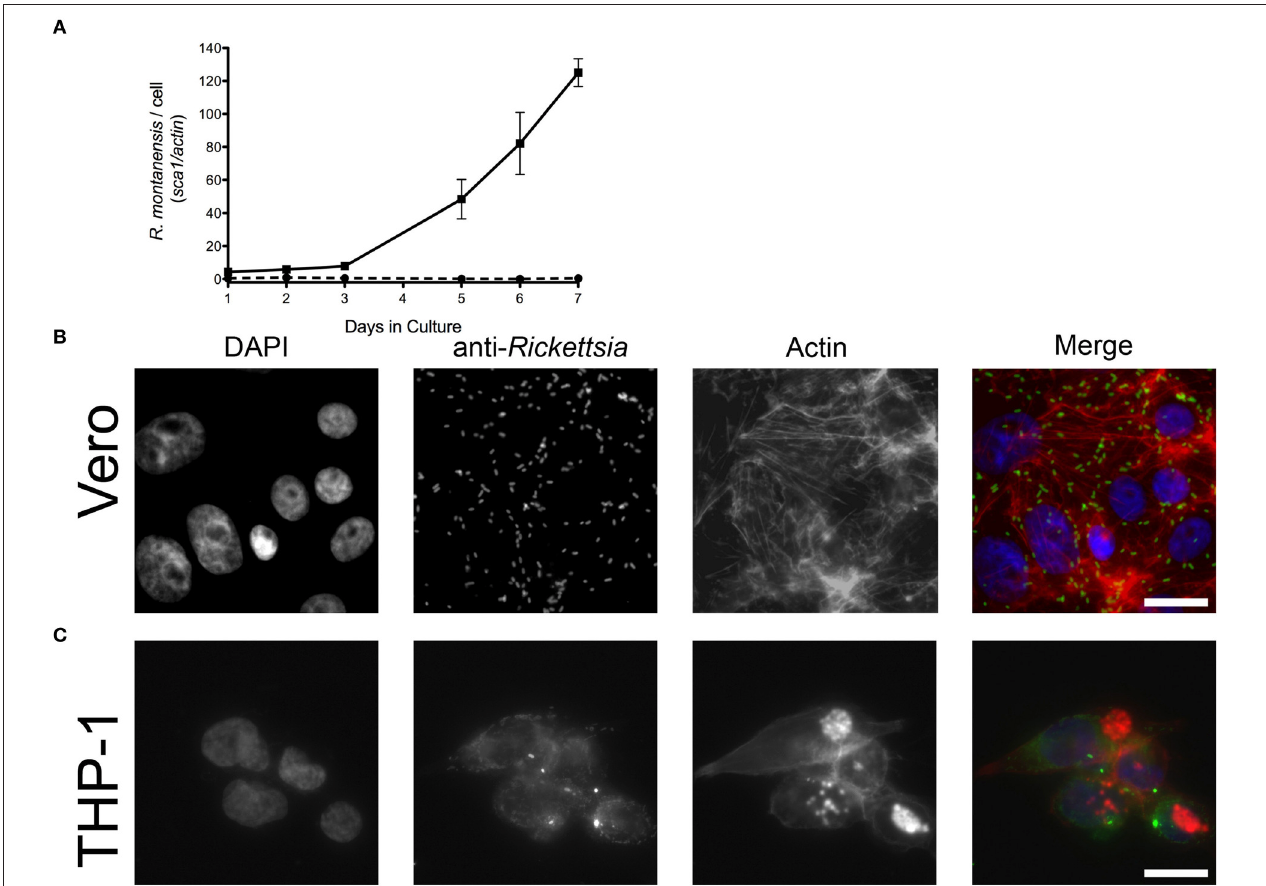
FIGURE 2 | R. montanensis is able to grow inside epithelial cells (Vero) but not in THP-1 derived macrophages. (A) PMA-differentiated THP-1 cells (dashed lines) and Vero cells (solid lines) were infected with R. montanensis, and genomic DNA was extracted at different time-points after infection. Quantitative PCR data are expressed as the ratio of R. montanensis sca1 vs. actin DNA content. (B , C) Immunofluorescence microscopy of Vero cells (B) and THP-1-derived macrophages (C) infected with R. montanensis at 3 days after infection. Cells were stained with DAPI (blue) to stain host nuclei, Phalloidin (red) to stain actin and rabbit anti- Rickettsia polyclonal antibody NIH/RML I7198 followed by Alexa Fluor 488 (green) to stain R. montanensis . Scale bar = 10 µ m.